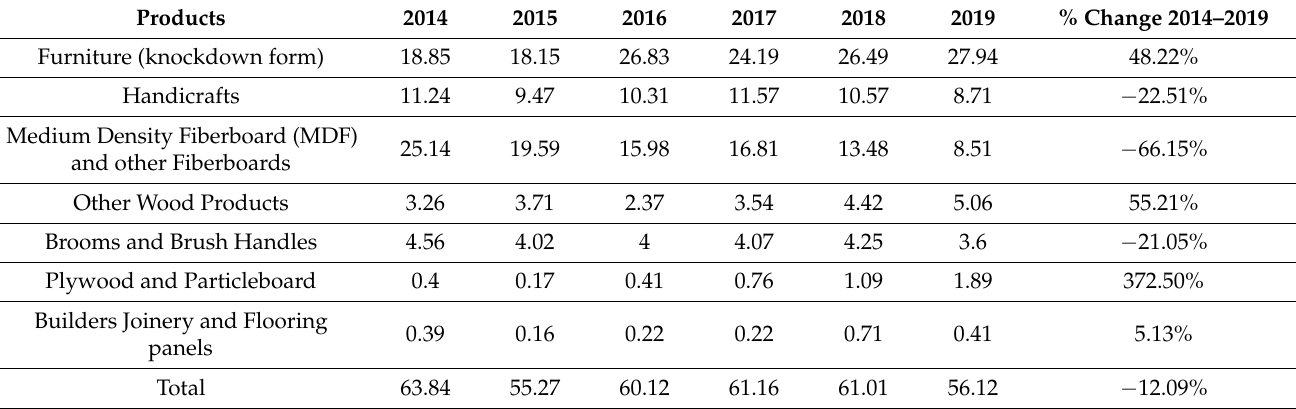
Table 1. Wood products exports from Sri Lanka (2014–2019) (sorted by 2019 values, USD ($)